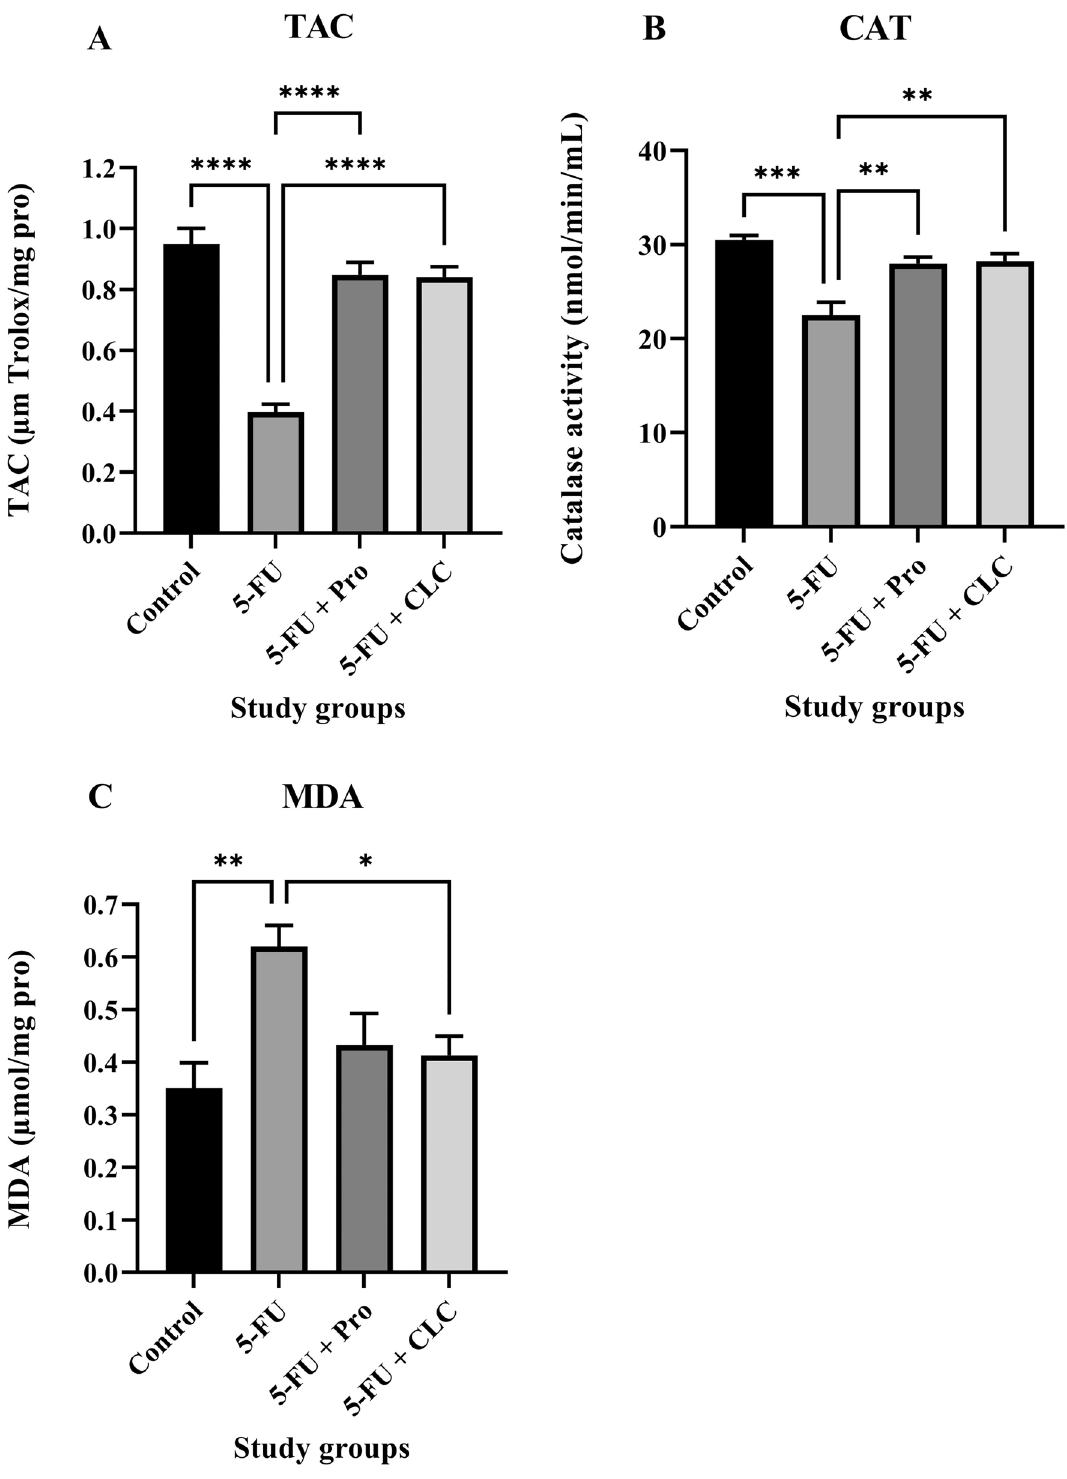
Figure 6. Effect of 5-flurouracil and propolis administration on the ( A ) TAC, ( B ) MDA, and ( C ) CAT status of the serum samples. Values are expressed as mean ± standard deviation (SD). Groups: Control, Normal saline; 5-FU, 5-FU 125 mg/kg; 5-FU + Pro, 5-FU 125 mg/kg + Propolis ethanolic extract 250 mg/kg/d; 5-FU + CLC, 5-FU 125 mg/kg + Colchicine 5 mg/kg/d. * , ** , *** , and **** indicate p < 0.05, p < 0.01, p < 0.001, and p < 0.0001,